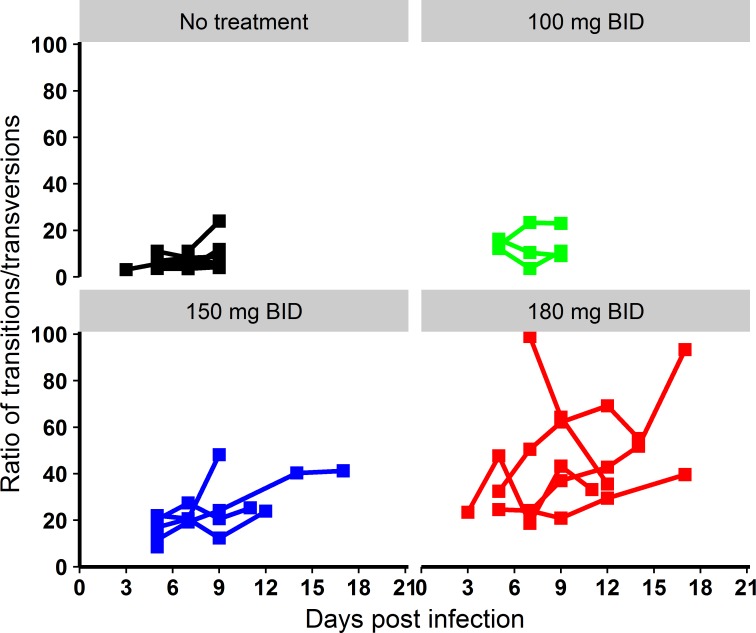
Evolution of the transition/transversion ratio overtime.Black: untreated; green: 100 mg/kg BID; blue: 150 mg/kg BID; red: 180 mg/kg BID.